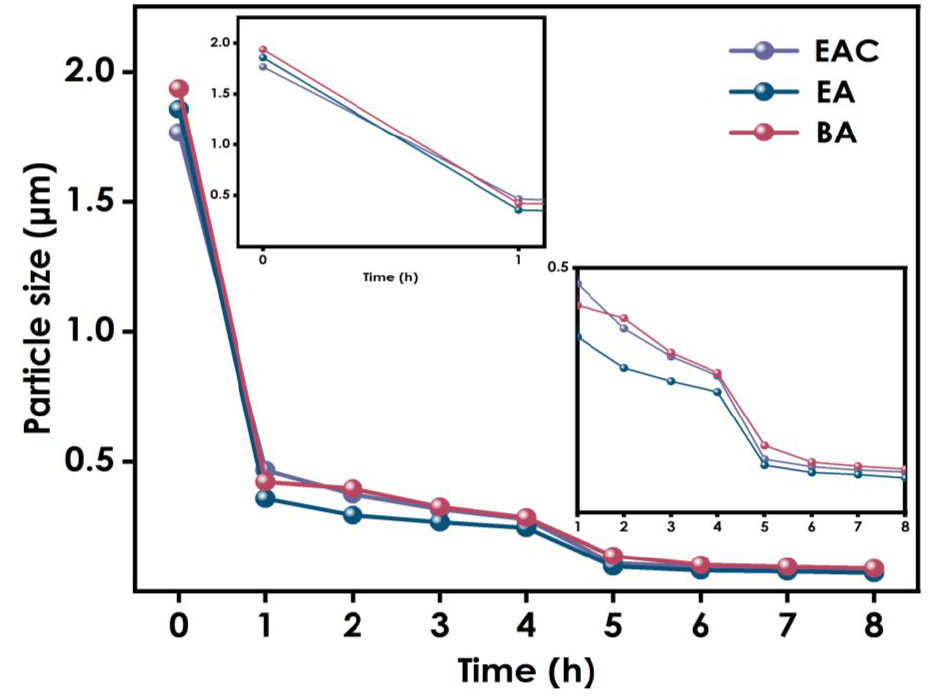
Figure 3. Particle size variation using different solvents.